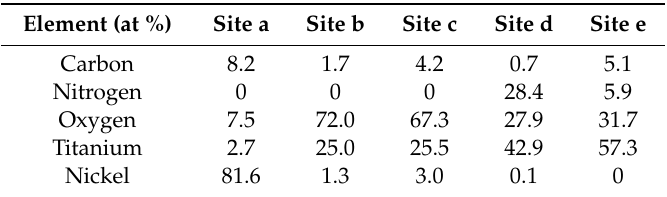
Figure 1. SEM micrographs of ( a ) T2N8-850, ( b ) T5N5-850, ( c ) T8N2-850. ( d ) A high magnification view of ( c ). Table 1. Chemical composition of T8N2-850 (Figure 1d) detected by EDS. The detected areas a, b, c, d and e are marked in Figure 1.